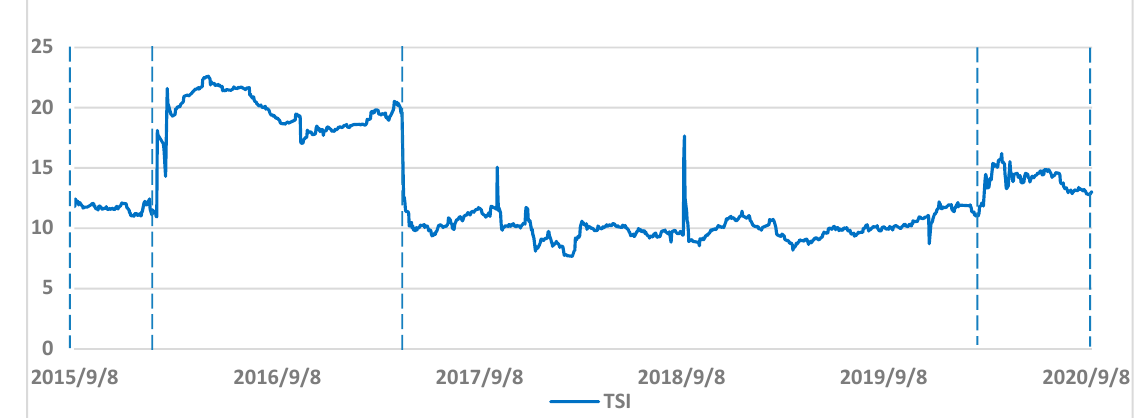
Figure 4. Dynamic total connectedness index with rolling windows. The length of the rolling window is 300 days and the date in the figure is the last day of each rolling window.